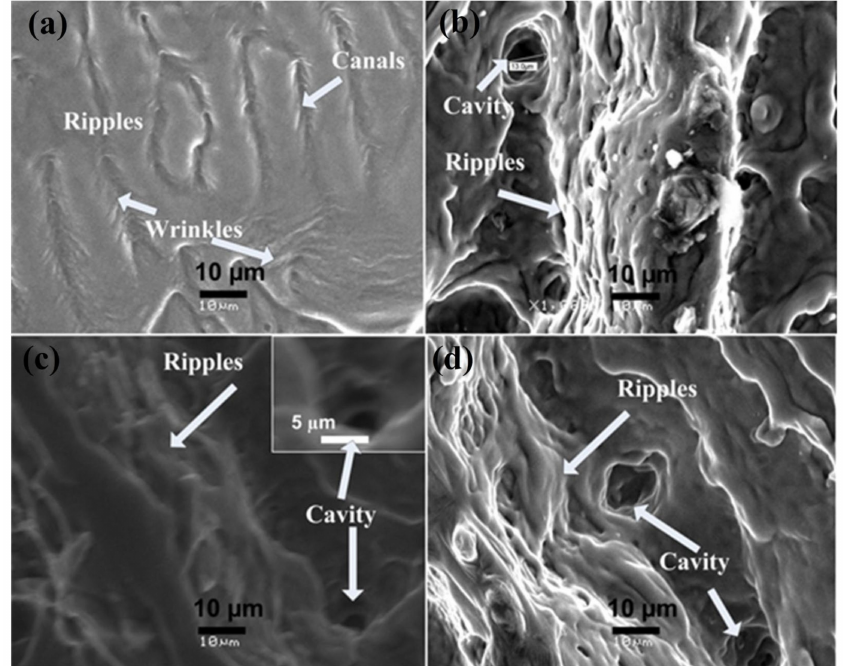
Figure 4. Magnified SEM images of Figure 3a–d, representing the surface morphology of the central ablated area of Al exposed to 100 pulses of ns laser at wavelength of 248 nm, pulse duration of 18 ns and repetition rate of 20 Hz at various fluences of ( a ) 0.86 J · cm − 2 , ( b ) 1 J · cm − 2 , ( c ) 1.13 J · cm − 2 and ( d ) 1.27 J · cm − 2 , under an ambient environment of O 2 at a pressure of 100